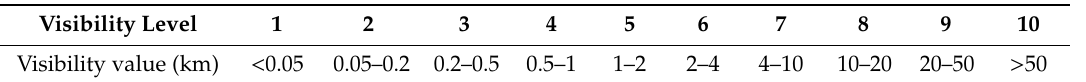
Table 1. The rule classifying the Vis level.